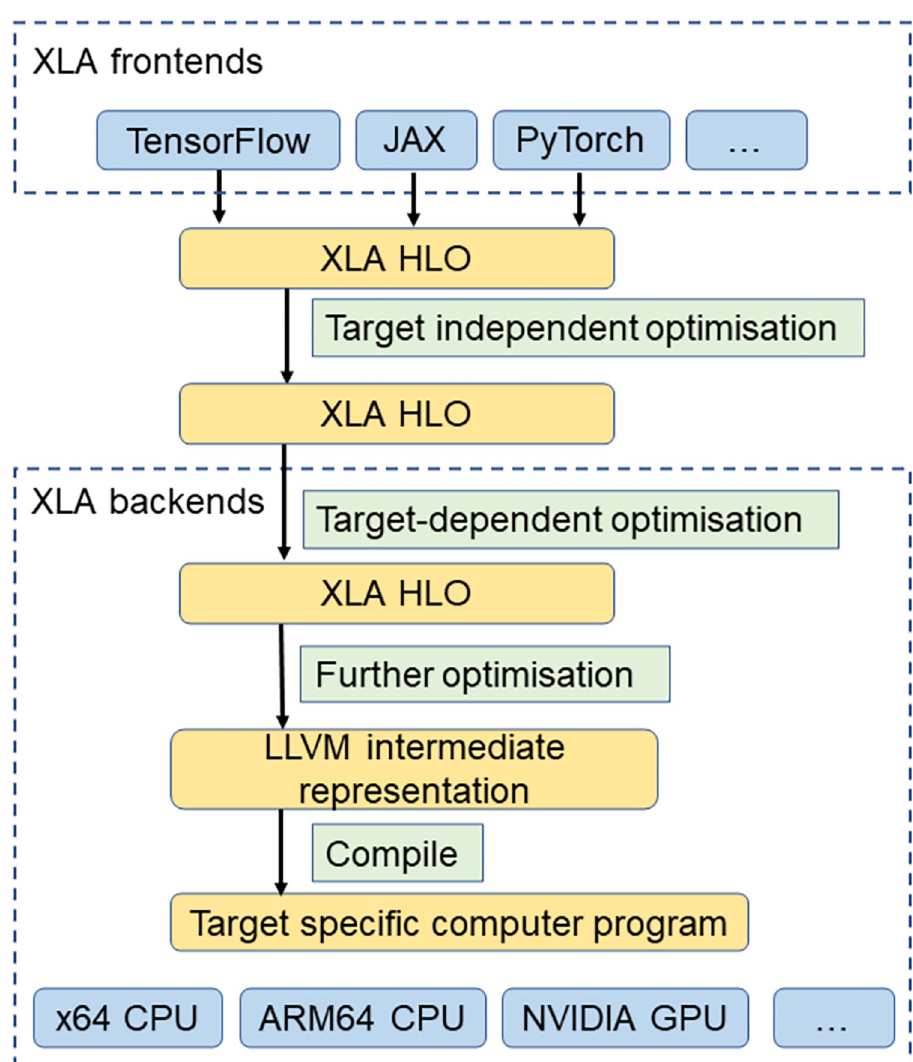
Fig 1. Architecture of accelerated linear algebra (XLA)